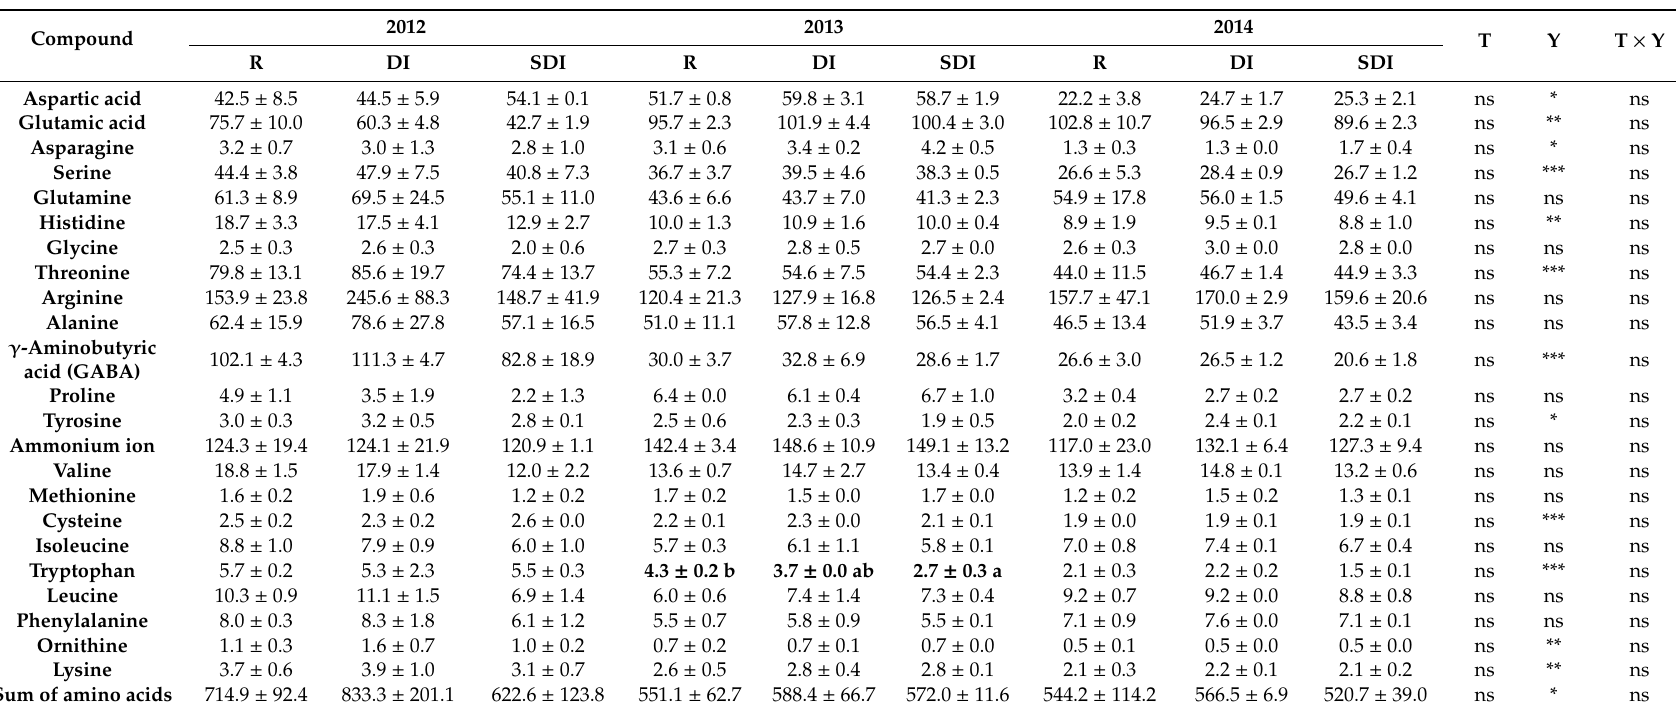
Table 5. Irrigation e ff ects on the amino acid concentrations (mean ± standard error, mg L − 1 ) of Godello musts. The significances of the factors year and treatment, as well as their interaction are shown. R = rain-fed, DI = drip irrigation, SDI = subsurface drip irrigation, T = Treatment, Y = Year.